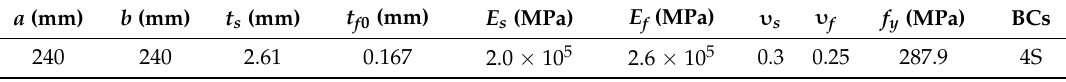
Figure 7. A classic perforated plate strengthened with FRP. Table 1. The basic geometry and material parameters. BCs: Boundary